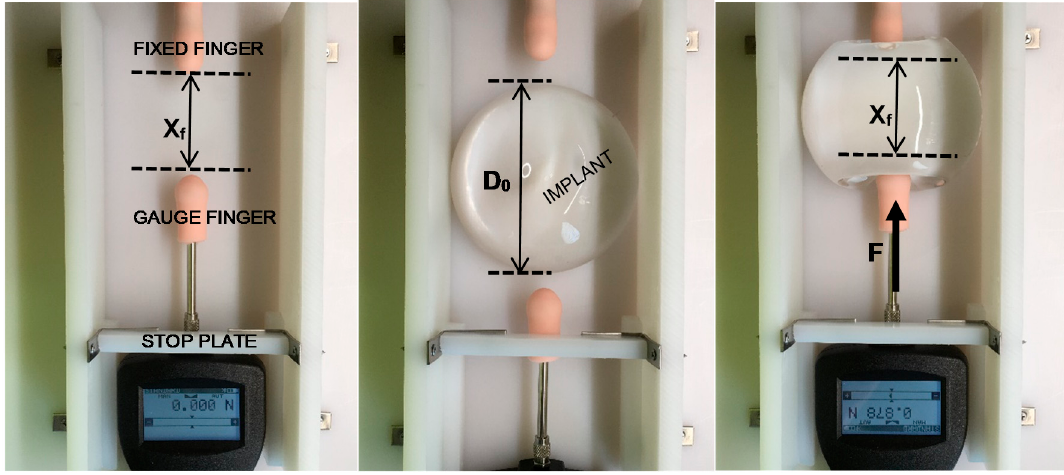
Figure 17. Setup for X f ( left ), Implant Placement ( center ), Implant Pinched for Force Measurement ( right ).